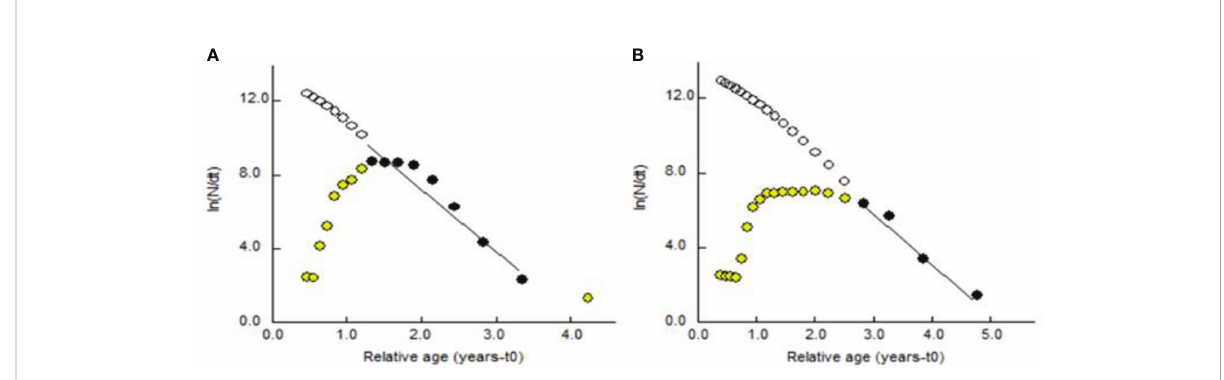
FIGURE 14 Length-converted catch curve of (A) male and (B) female P. adspersus from the southeast Caspian Sea (2019 –